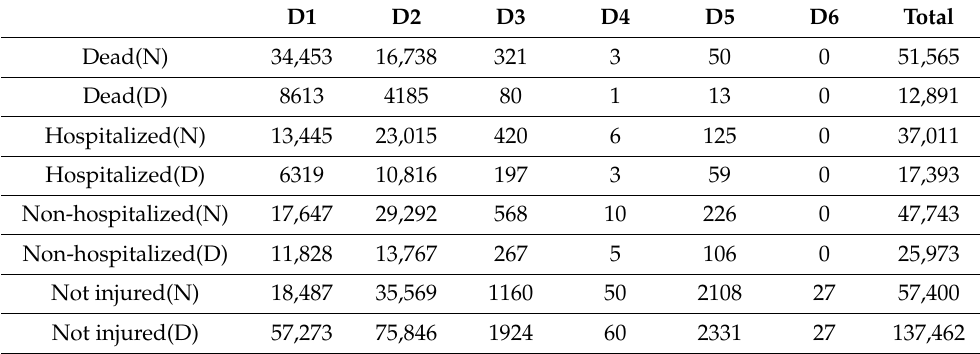
Table 10. Number of casualties in the 1721 earthquake in District 1 of Tabriz.